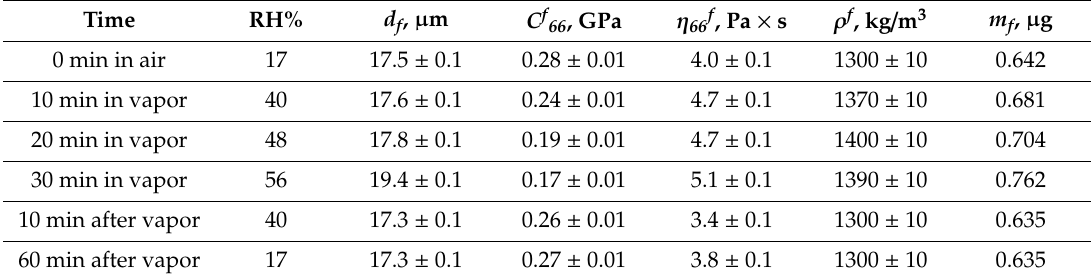
Table 3. Parameters of the mushroom G. lucidum mycelium film at di ff erent values of humidity.